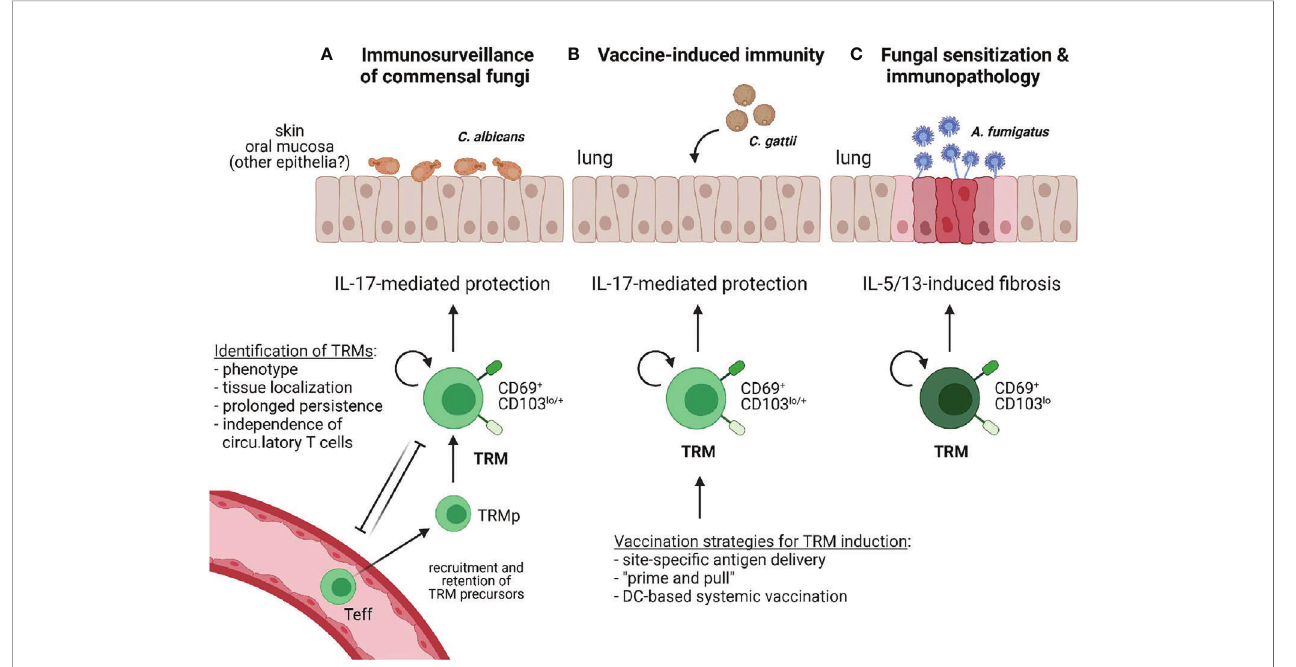
FIGURE 1 | Reported examples of TRMs in antifungal immunity. (A) IL-17 producing CD4 + TRMs provide immunosurveillance against commensal fungi (e.g. C. albicans ) that colonize barrier tissues such as the skin or the oral mucosa to prevent dysbiosis (23, 24). (B) Vaccine-induced immunity protects against fungal pathogens (e.g. C. gattii ) via elicitation of IL-17-producing CD4 + TRMs (25). Different vaccination strategies for TRM induction in barrier tissues are indicated. (C) Antifungal TRMs can promote in fl ammation and immunopathology, such as those induced by A. fumigatus sensitization in the airways